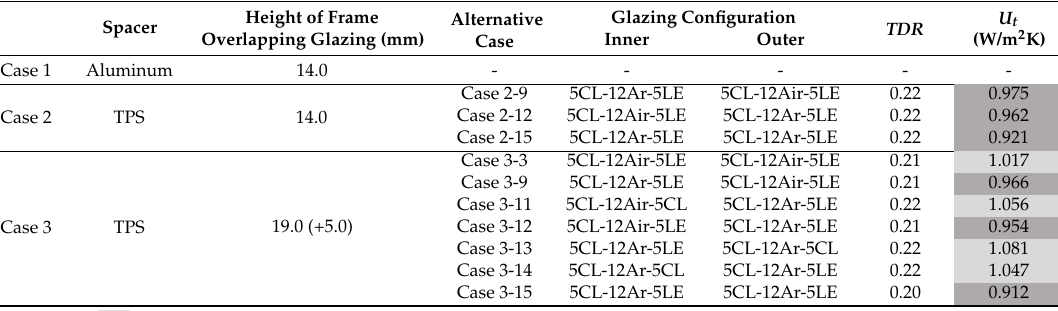
Table 9. TDR s and U-factors for cases satisfying the required TDR for Region I.